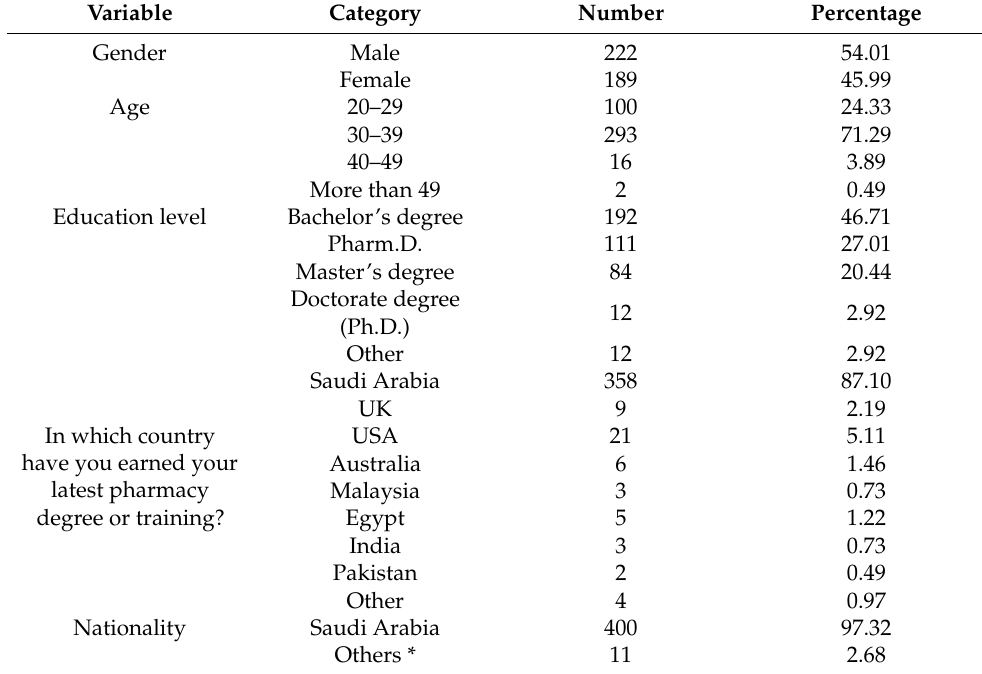
Table 1. Demographic data of the respondents (n =